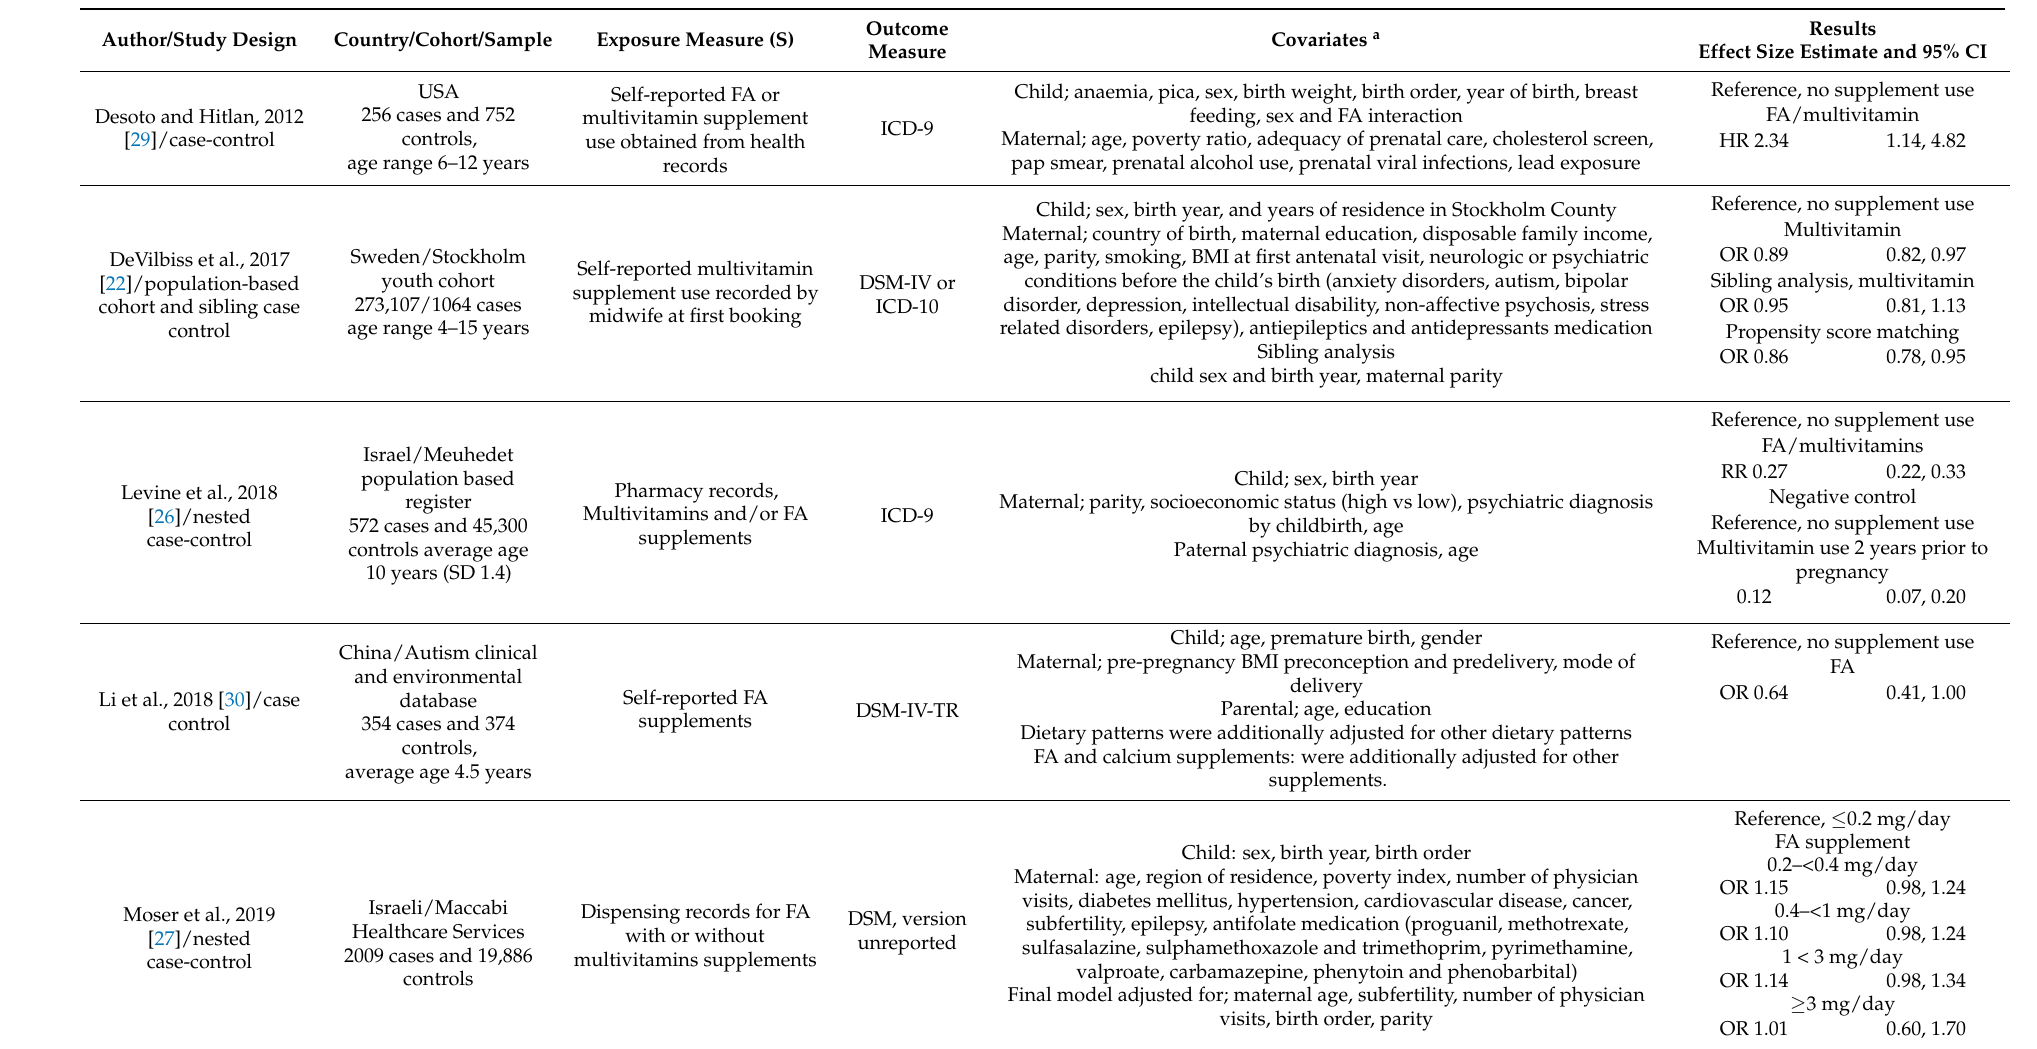
Table 3. Study characteristics and results from individual studies